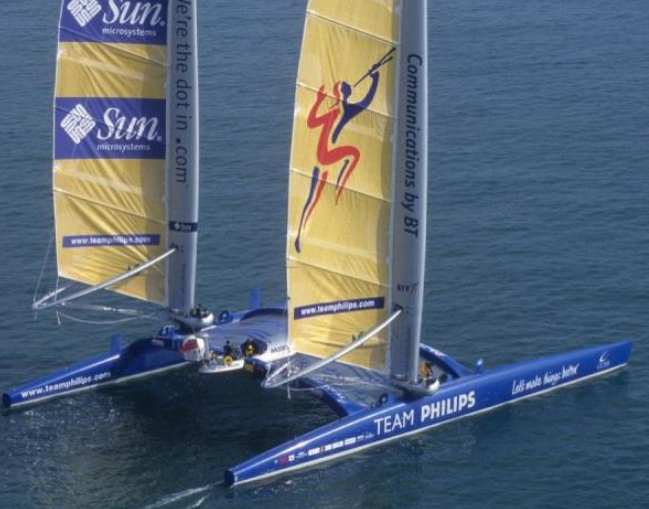
Figure 14. A Team Philips catamaran (reprinted with permission from Ref. [54]).